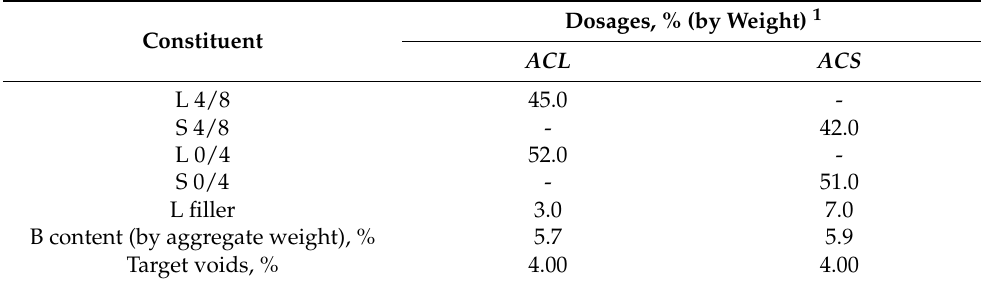
Table 2. Mix design of the produced asphalt mixtures.